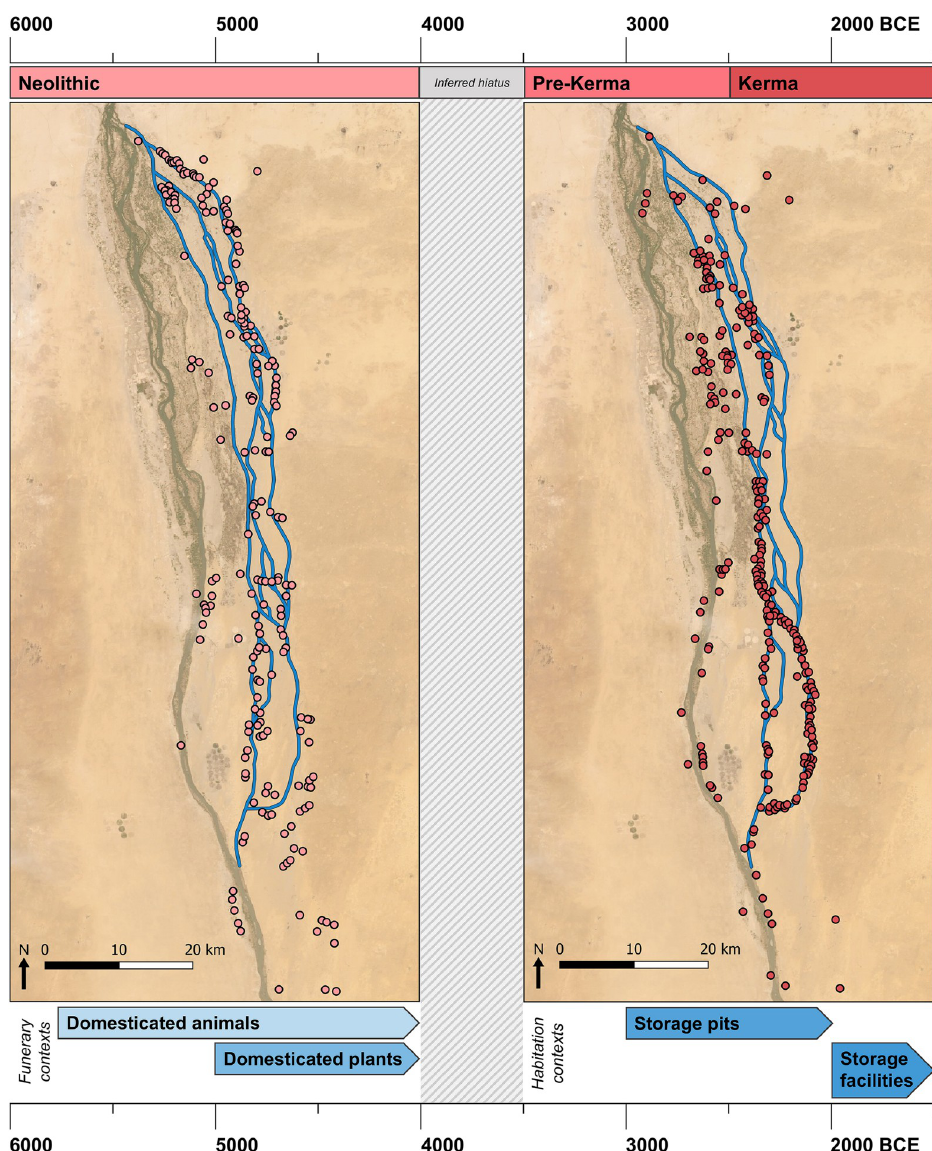
Fig 16. Changes in site distribution on the alluvial plain and corresponding evidence for food production economies. A) Distribution of Neolithic period sites on the alluvial plain; B) Distribution of pre-Kerma and Kerma period sites on the alluvial plain, note increased clustering along palaeochannels. Inferred hiatus between 4000–3500 BCE based on the limited evidence for a Late Neolithic presence on the alluvial plain which suggests a significant population reduction during this period. Site locations georeferenced using existing data [27, 32, 40]. World Imagery base map sourced from: Esri, Maxar, Earthstar Geophysics, and the GIS User Community (ArcGIS Pro Licence